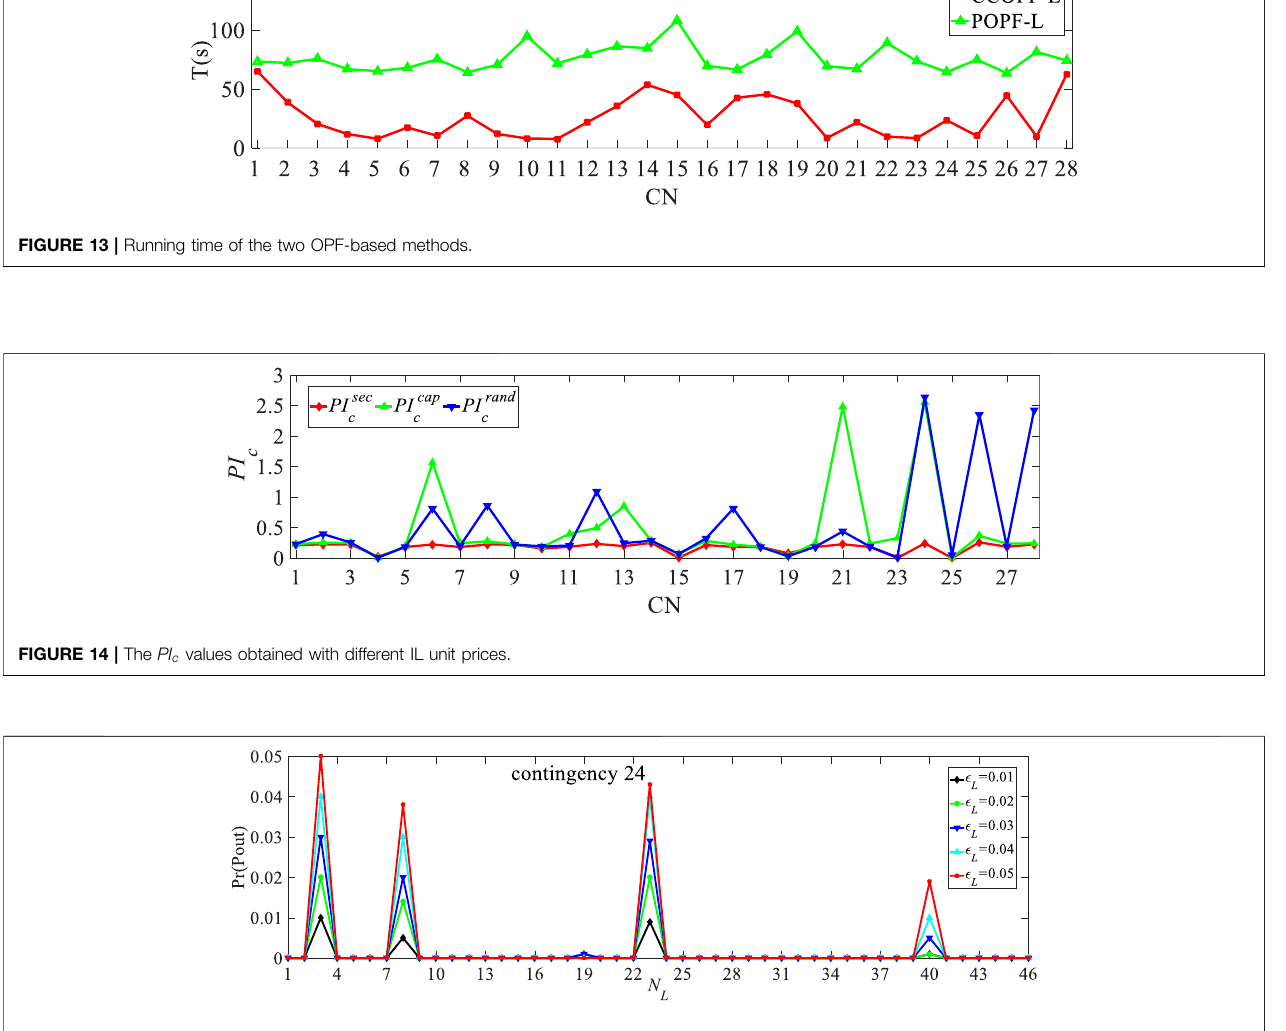
FIGURE 15 | Off-limit probability of branch power with different